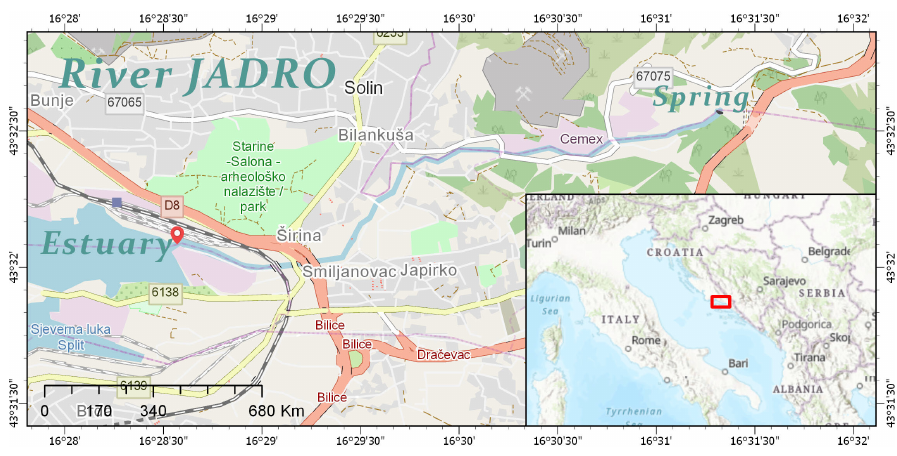
Figure 1. Case study